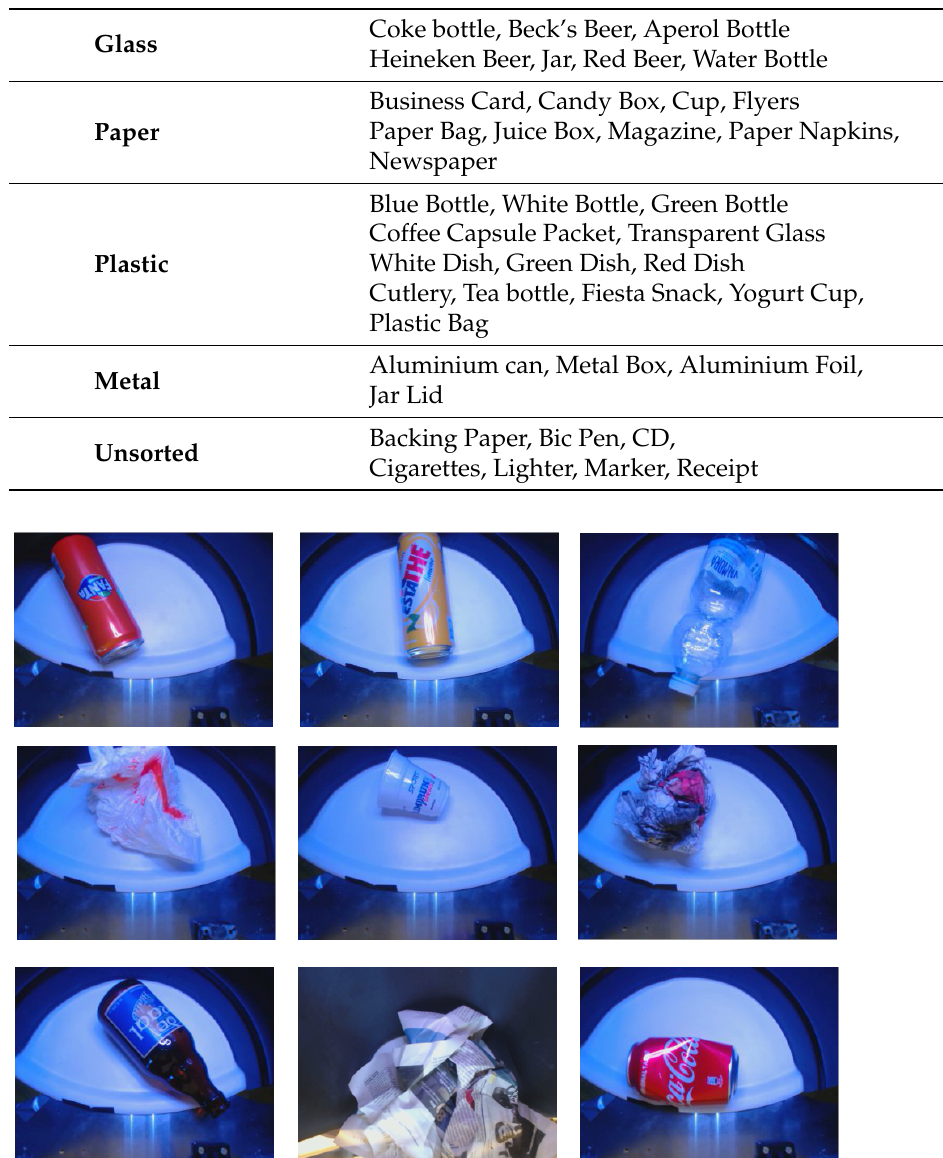
Table 1. List of objects contained in each waste class of the dataset.